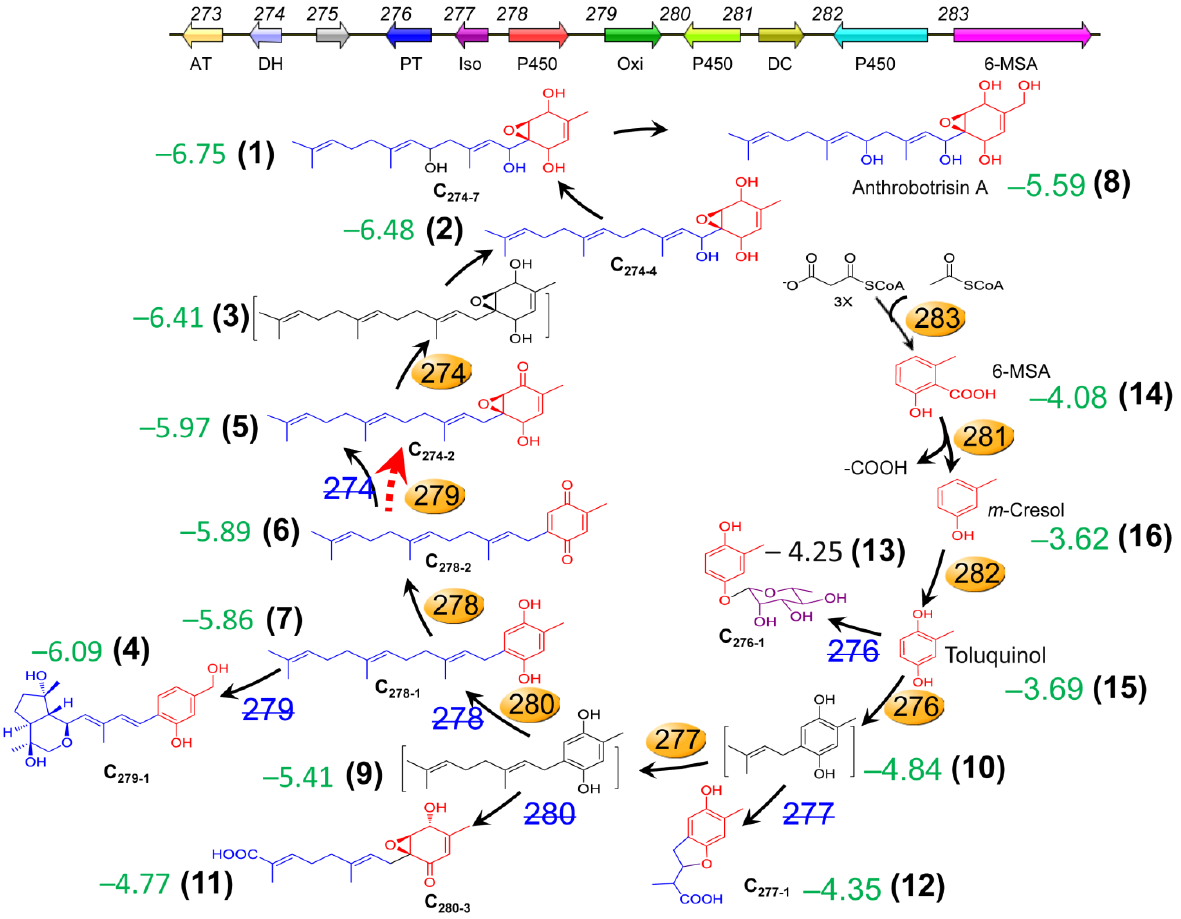
Figure 9. The hybrid metabolites derived from the PKS-PTS hybrid biosynthetic pathway with binding free energy values (referring to the binding affinity of SEC metabolites with 275) predicted by molecular docking analysis. All of the metabolites displayed binding free energy values below − 3 kcal/mol.